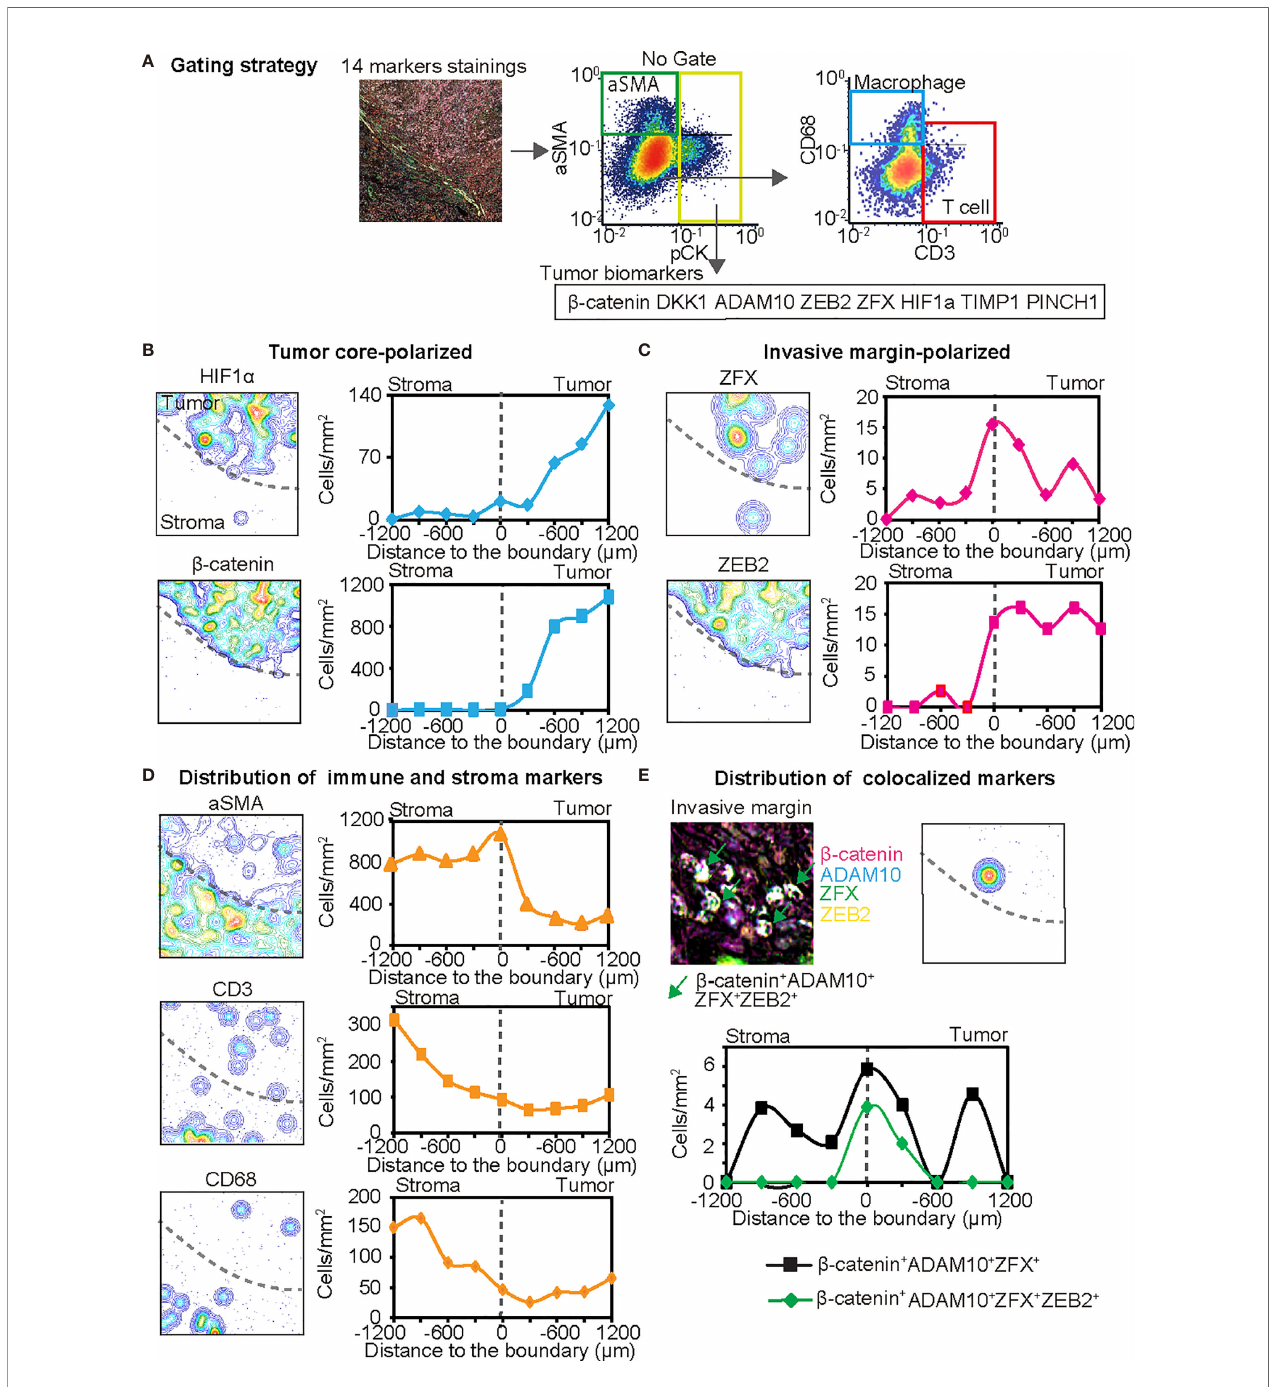
FIGURE 6 | The 14-biomarker multiplex IHC panel quantitatively assesses intratumoral heterogeneity of HNSCC. (A) The gating strategy used for single cell-based chromogenic signal intensity is shown where cell size/area, and location are utilized for density plots similar to fl ow cytometry. X and y axes were shown on a logarithmic scale. The gating strategies identi fi ed cell populations of pCK + tumor cells with selected tumor cell biomarkers such as b -catenin, DKK1, ADAM10, ZEB2, ZFX, HIF1 a , TIMP1, and PINCH1, together with aSMA + cells (pCK − aSMA + ), T cells (pCK − aSMA − CD3 + ) and macrophages (pCK − aSMA − CD68 + ) in a single tissue. (B – D) Left panels depict contour mapping based on cell density of each marker. Dash lines present the invasive margin between tumor cell nests and stroma. Right panels depict cell densities of identi fi ed lineages in every 200 µm-width from stroma to the tumor side. Tumor cell biomarkers are classi fi ed into tumor core-polarized (B) , and invasive margin-polarized markers, in comparison with immune and stroma markers (D) . (E) IHC image and pixel density contour graph indicate distribution of colocalized markers at the invasive margin. Line graph show two colocalized markers. Black line shows b -catenin + DKK1 + ADAM10 + ZFX + cells and green line showed b -catenin + DKK1 + ADAM10 + ZFX + ZEB2 +